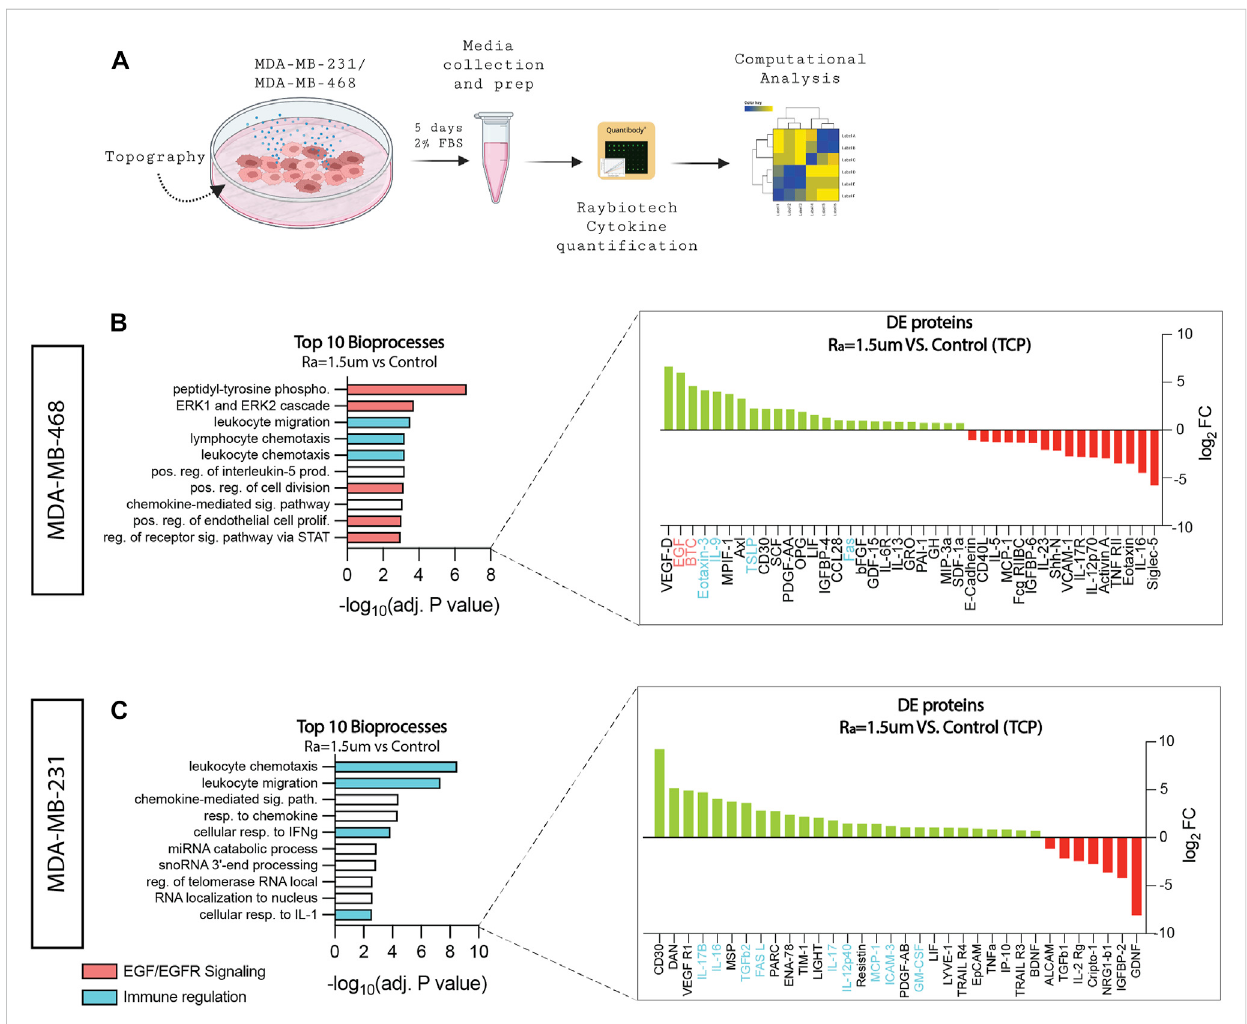
FIGURE 2 Surface roughness enhances bioprocesses associated with in fl ammation and EGF/EGFR signaling. (A) Schematic diagram of the work fl ow used to collect the conditioned media samples for cytokine quanti fi cation. (B) GO top 10 enriched bioprocesses and differentially upregulated (green) and downregulated (red) proteins of MDA-MB-468 cells cultured in surface roughness (Ra = 1.5 µm), revealing enhancement in pathways related to EGF/ EGFR signaling and immune regulation (adj. p < 0.01). (C) GO top 10 enriched bioprocesses and differentially upregulated (green) and downregulated (red) proteins of MDA-MB-231 cells cultured in surface roughness (Ra = 1.5 µm), revealing enhancement in pathways related to immune regulation (adj. p < 0.01).